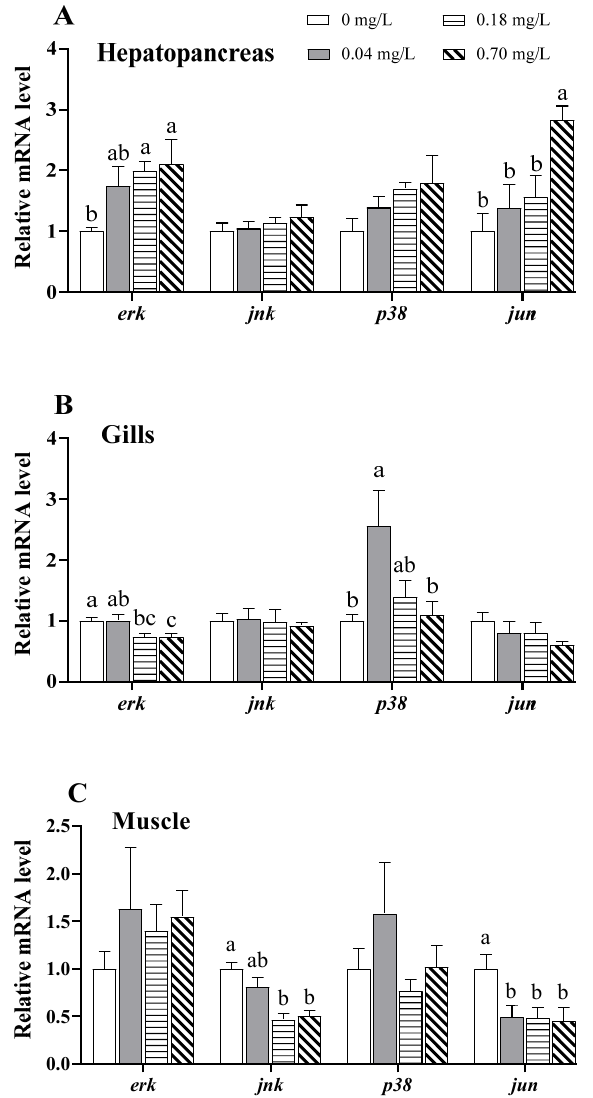
Figure 4. Expression of MAPK pathway-related genes in different tissues of E. sinensis exposed to copper for 5 days. ( A ) Hepatopancreas; ( B ) gills; ( C ) muscle. The values are expressed as the mean ± SEM ( n = 6). Different letters denote significant differences among different groups ( p < 0.05).